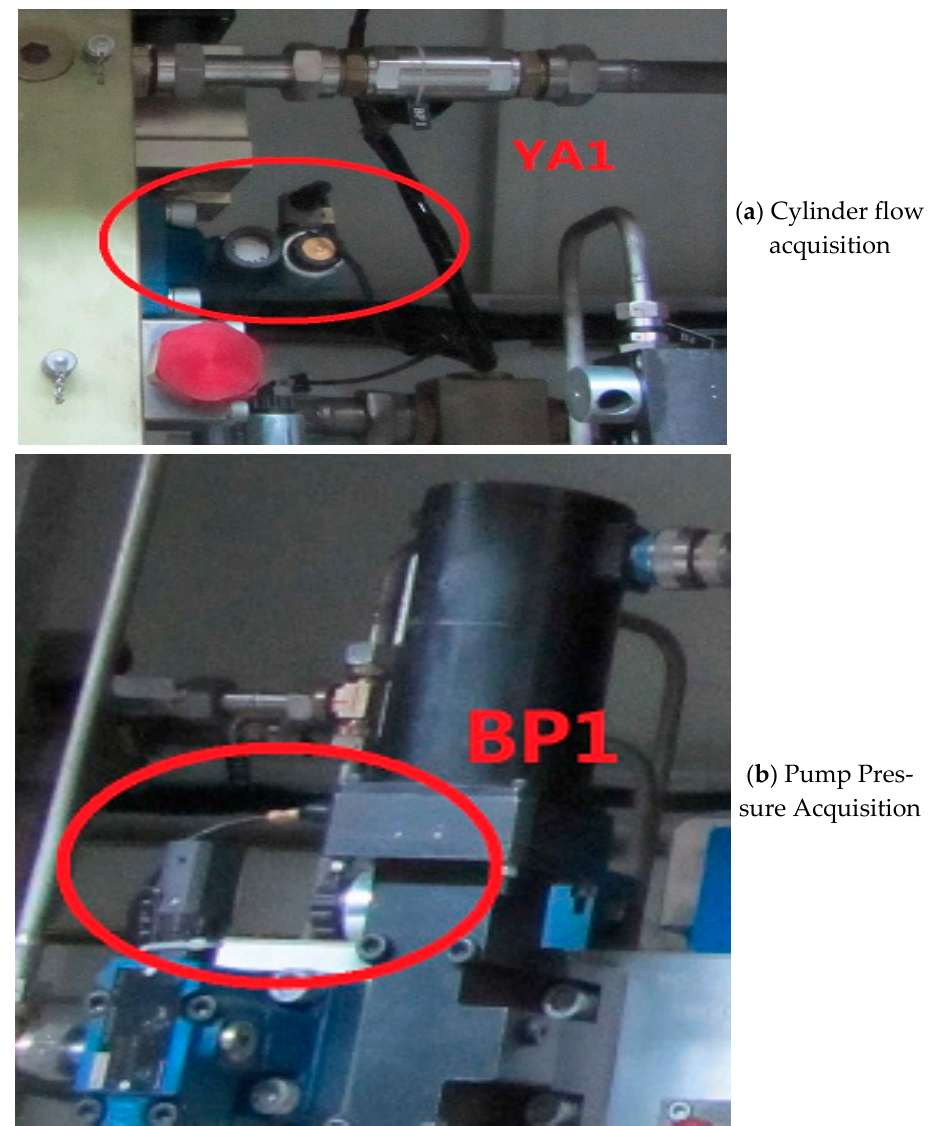
Figure 2. Cylinder and pump in the hydraulic control